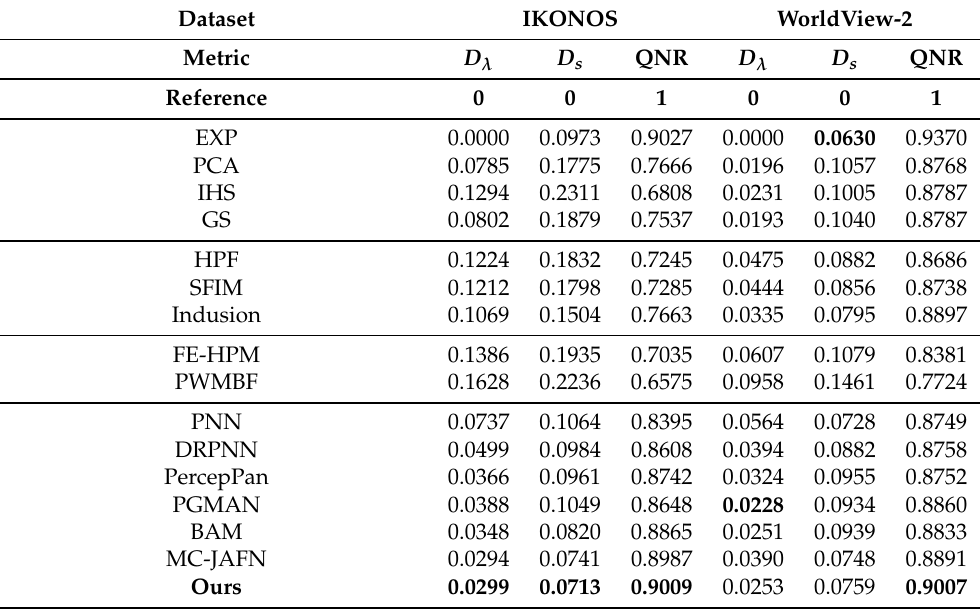
Table 4. Quantitative Evaluation for Real Dataset. The Best Results are Shown in Bold